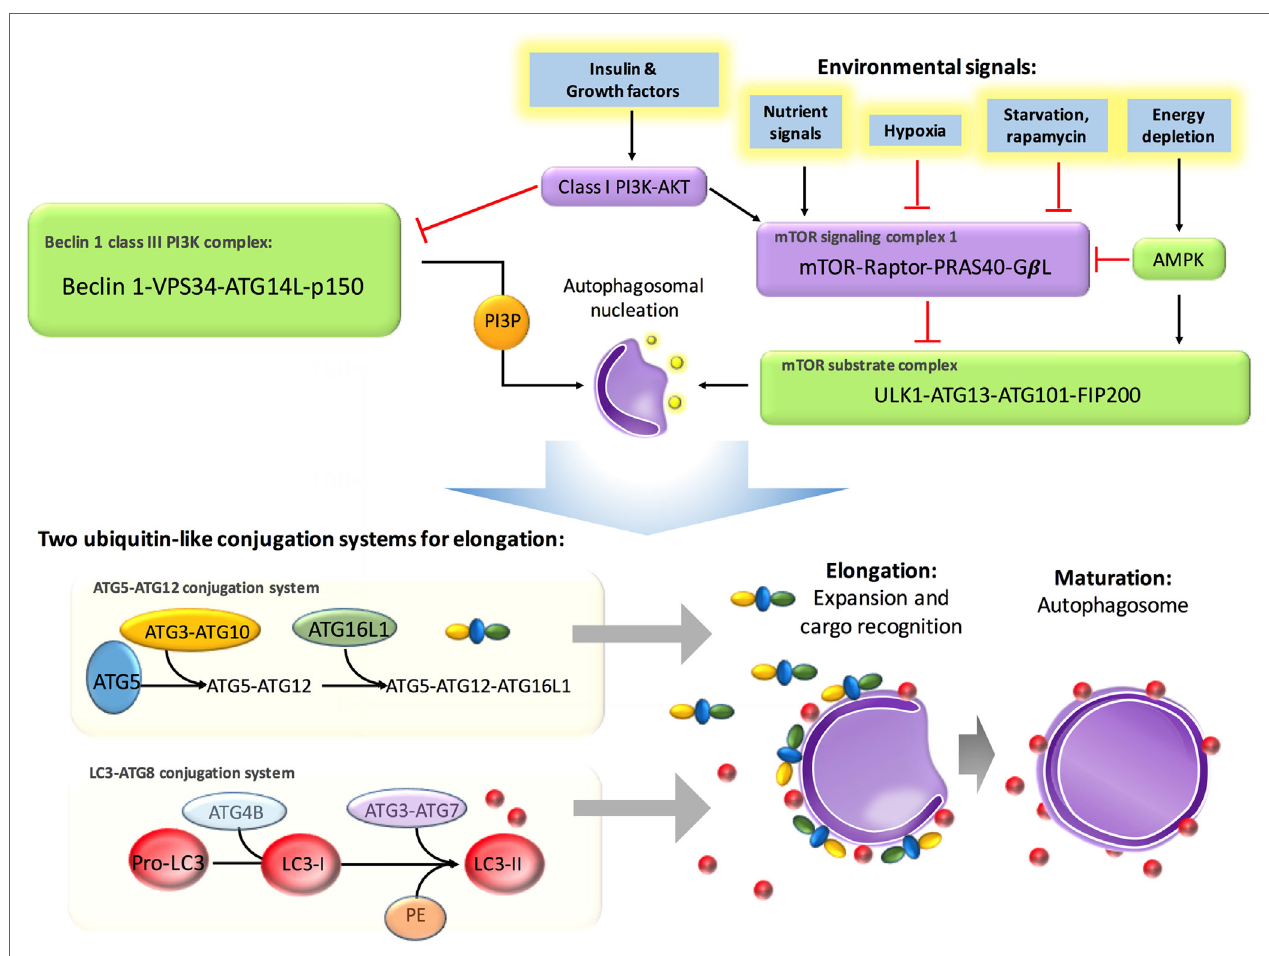
FigURe 2 | Molecular regulation in autophagy. Autophagy is suppressed by insulin and other growth factor signaling, starvation, and nutrient signals but activated by energy depletion and AMBRAs, BIF1, and UVRAG. Energy depletion can activate AMP­activated protein kinase (AMPK) and further activate the mammalian target of rapamycin (mTOR) substrate complex, which consists of phosphorylated UNC­51­like kinase 1 (ULK1), ATG13, ATG101, and FIP200. In addition, this pathway positively regulates the formation of autophagosomes. Environmental signals, such as starvation, repress autophagy via inhibition of mTOR, which is located in the mTOR signaling complex 1, formed by the regulatory­associated protein of mTOR (Raptor), G protein beta subunit­like protein (G β L), and proline­rich Akt/PKB substrate 40 kDa (PRAS40). Insulin and other growth factor signaling activates class I PI3K–Akt, which inhibits autophagy via activation of mTOR signaling complex 1 and inhibition of the Beclin 1 class III PI3K complex, which contains Beclin 1, class III phosphatidylinositol­3­kinase (PIK3C3), and ATG14L. Autophagosomal elongation requires two ubiquitin­like conjugation systems: the ATG5–ATG12 conjugation system and light­chain 3–ATG8 conjugation